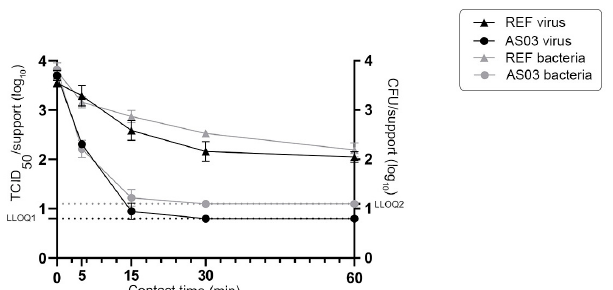
Figure 7. Survival of both murine norovirus and Enterococcus faecium on stainless steel and AS03 supports after mixture transfer. LLOQ: lower limit of quantification (LLOQ1 = 0.8 log 10 TCID 50 and LLOQ2 = 1.1 log 10 CFU). Mean values ± SD corresponding to 10 inoculated supports for each time point.